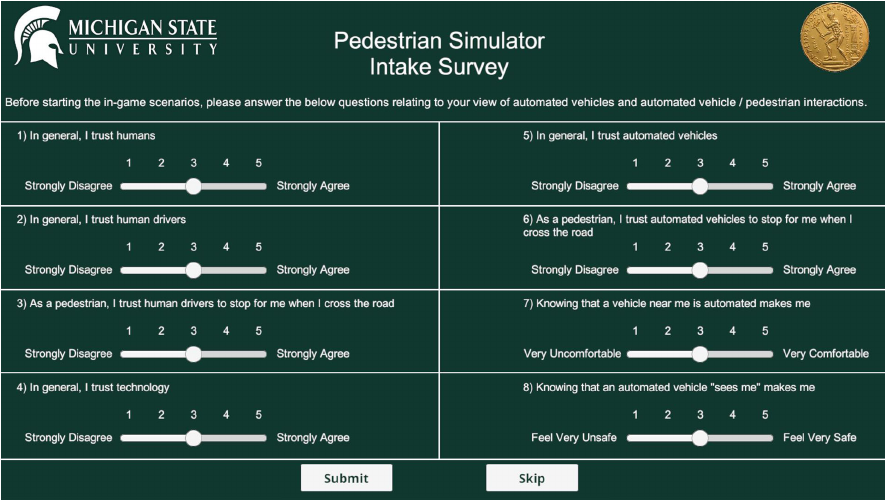
Figure 5. This survey appears after a user completes the third scenario.